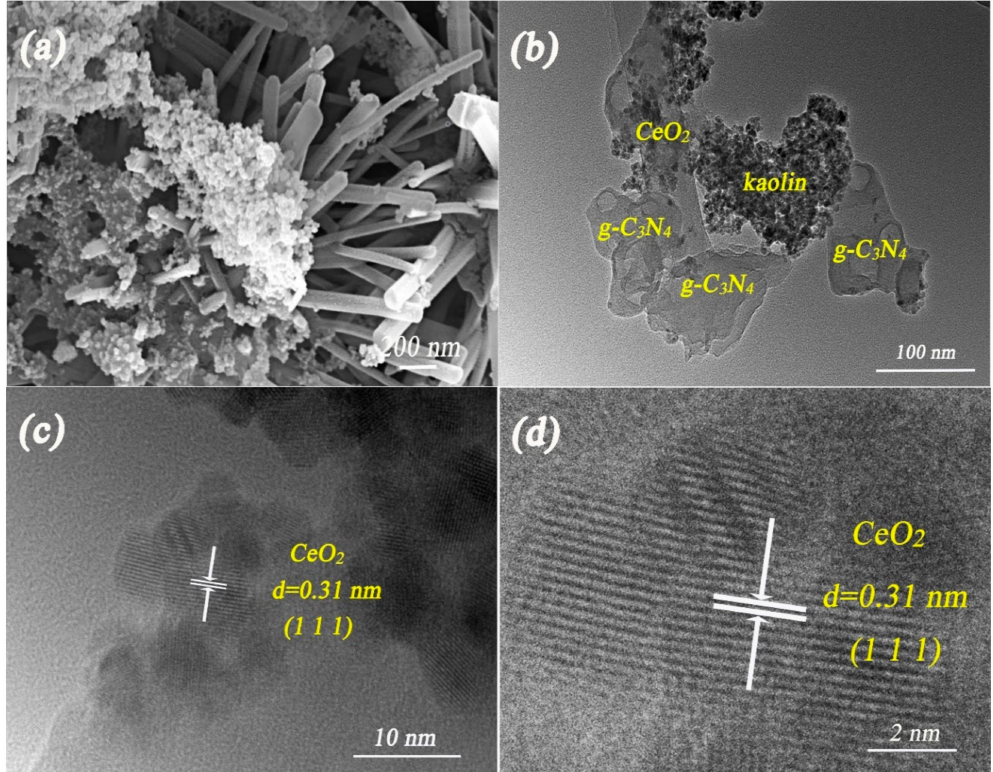
Figure 3. FESEM images of kaolin / CeO 2 / g-C 3 N 4 composite ( a ); TEM ( b ) and HRTEM images ( c , d ) of kaolin / CeO 2 / g-C 3 N 4